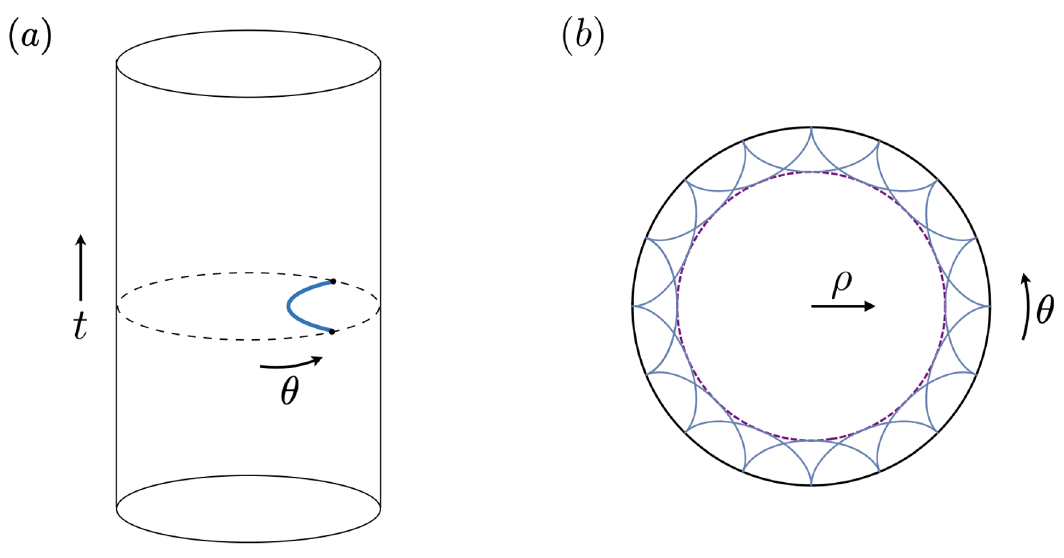
Figure 1 . (a) Kinematic space can be defined as the space of pairs of spacelike separated points in a CFT, which are in correspondence with bulk minimal area spacelike geodesics ending on these points. The blue curve is one such geodesic, in the special case that the endpoints lie on the same time slice. (b) The parallel transport of operators in kinematic space can be related to lengths in the bulk AdS spacetime. Depicted here is a constant time slice of anti-de Sitter spacetime. Pairs of points on the boundary define bulk geodesics (blue, solid curves). As the interval position is varied, these trace out an envelope in the bulk (dashed purple circle). The length of this envelope is directly related to the Berry phase associated to the boundary parallel transport of bilocal operators evaluated at the endpoints